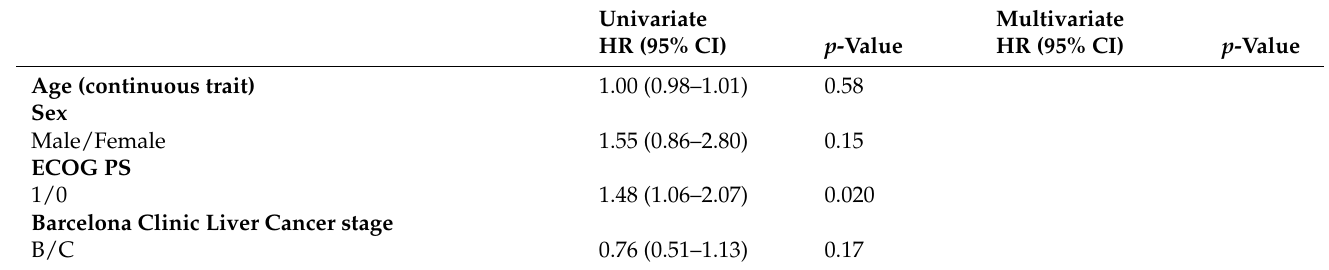
Table 3. Univariate and multivariate Cox analysis of factors associated with overall survival in 174 HCC patients undergoing second-line